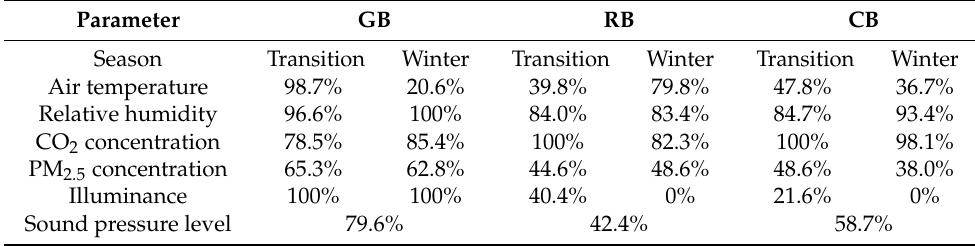
Table 6. Compliance rates of different indoor environment